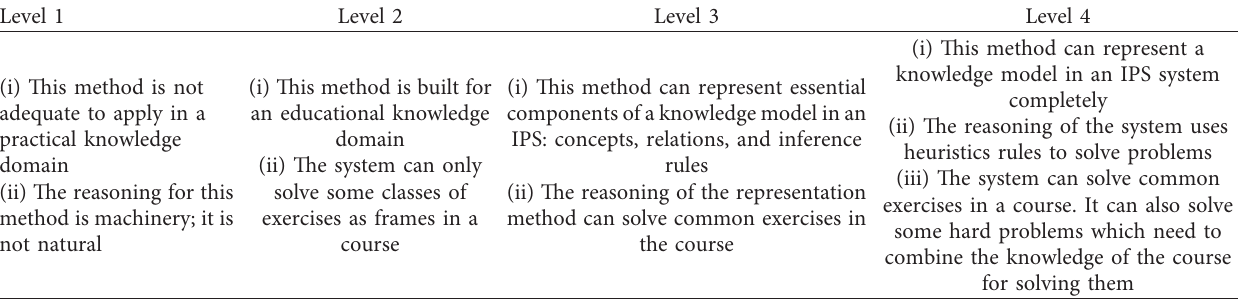
Table 3: Levels of usability